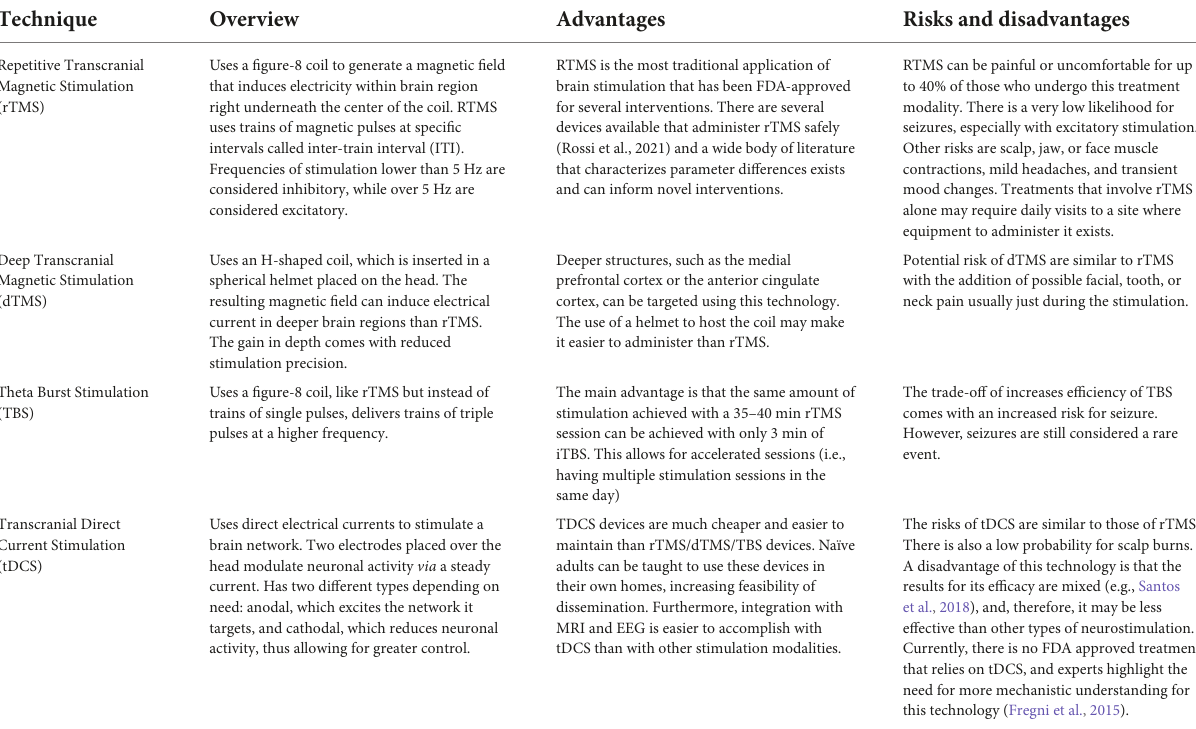
TABLE 3 Overview, advantages, and risks of various neurostimulation